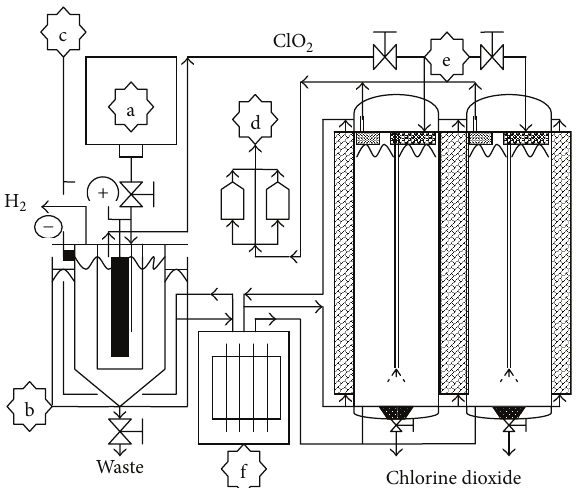
Figure 1: Designed chlorine dioxide electrolysis equipment: (a) material, (b) electrolyzer, (c) electronic control system, (d) air pump, (e) collecting tank, and (f) cooling